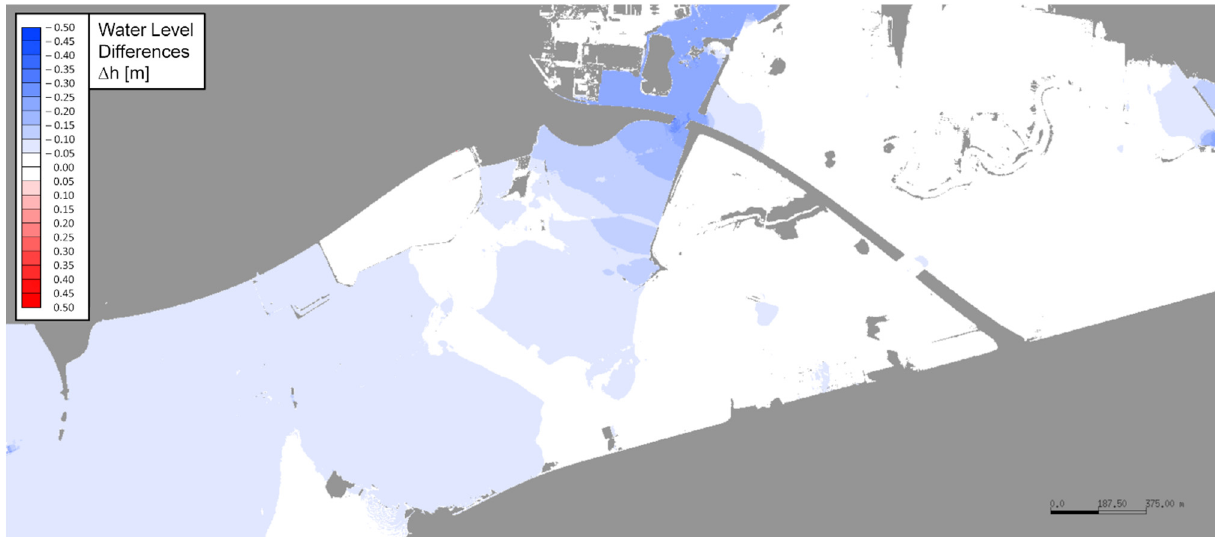
Figure 12. Flow depth differences between a calculation with and without vegetation resistance. Bed resistance is accounted for in both cases. Grey indicates dry areas.